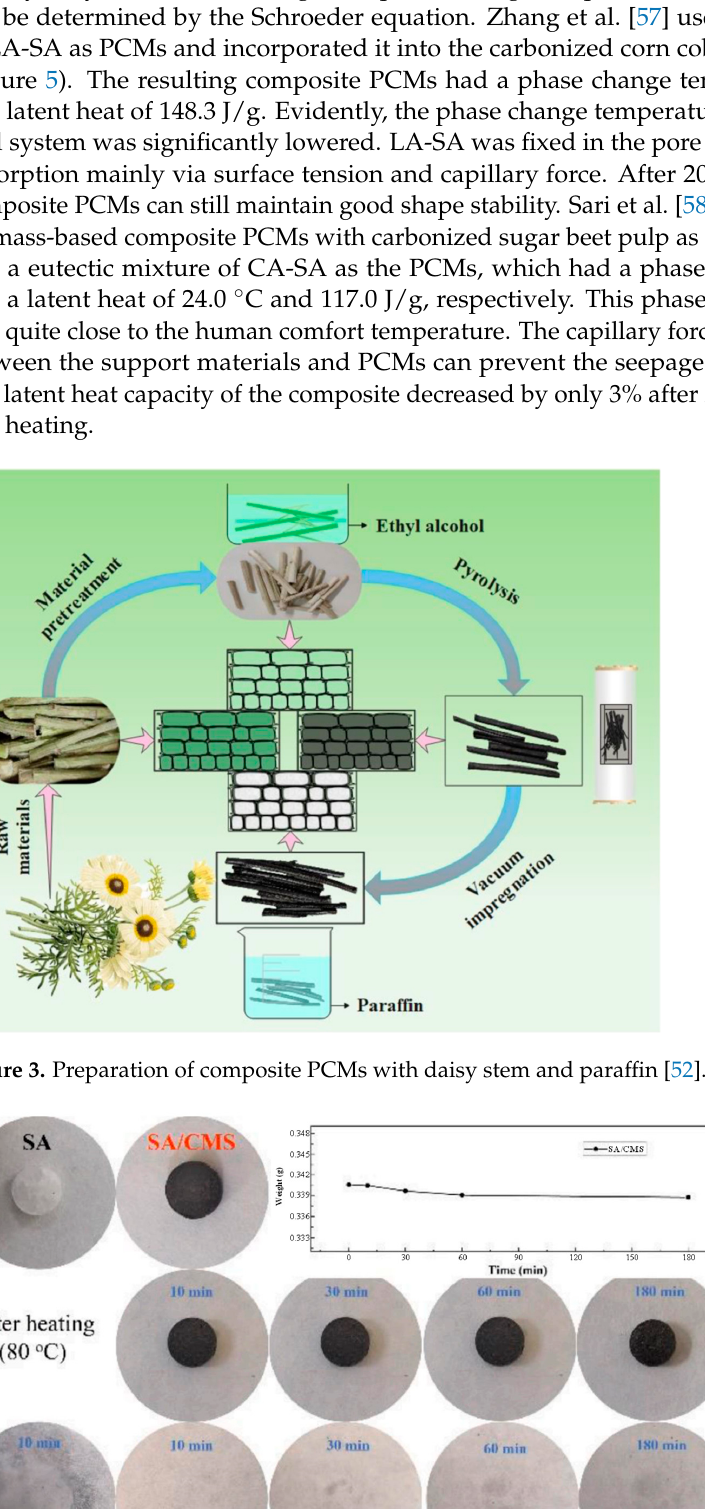
Figure 5. Preparation process of composite PCMs with carbonized corn cob and LA-SA [57]. However, fatty acids are mostly derived from animals and plants, and biomass ma- terials are easily influenced by microorganisms. Therefore, it is necessary to further ex- plore the biological durability of fatty acid–biomass composite PCMs.